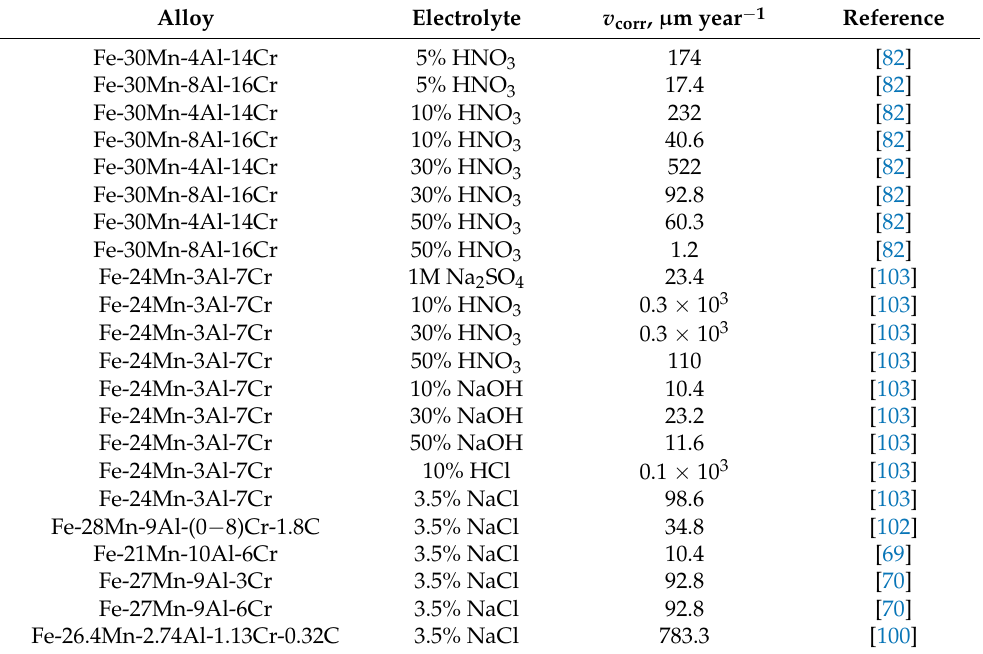
Table 3. Corrosion rate ( v corr ) ( µ m year − 1 ) values for high-Mn TWIP steels with aluminum and chromium